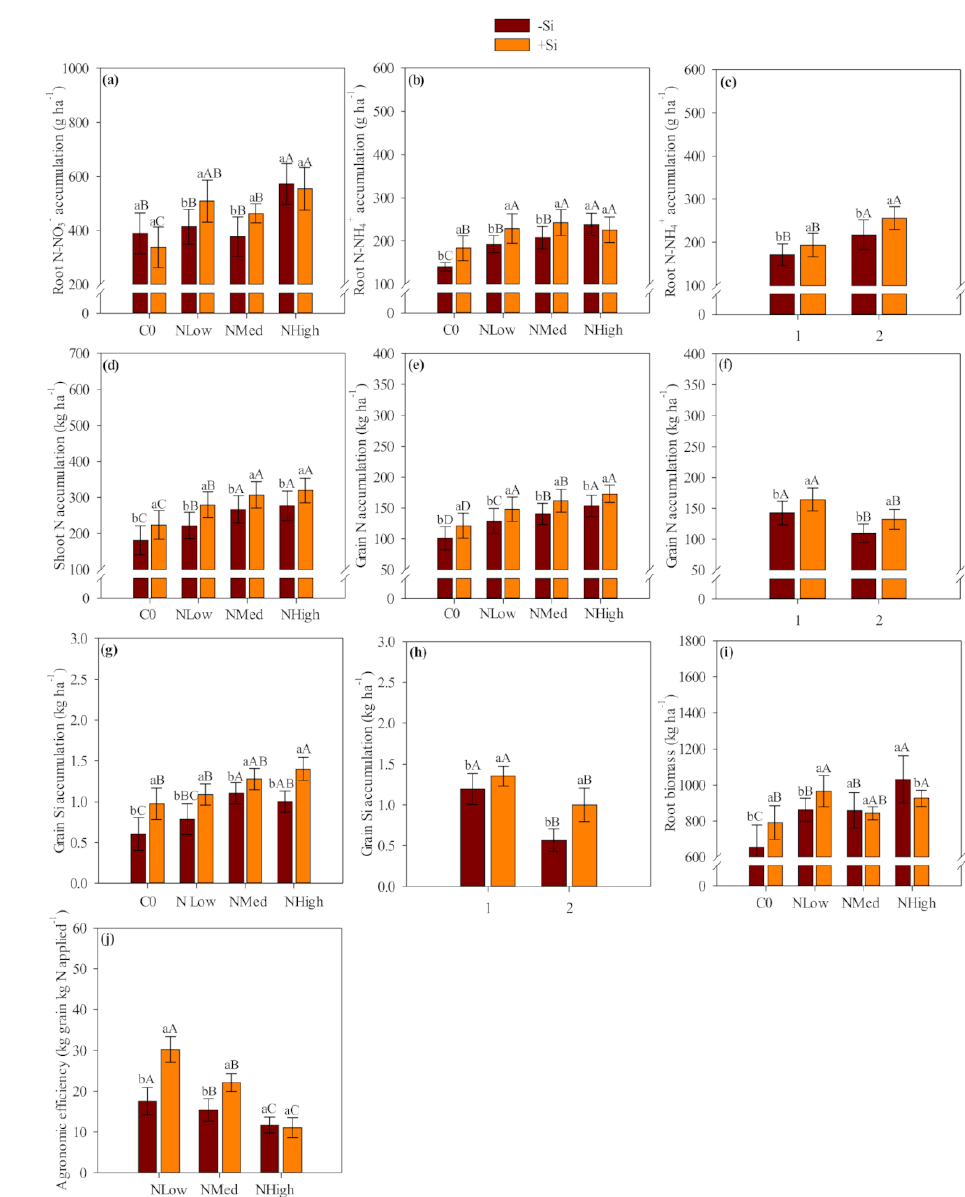
Figure 1. Maize root nitrate (N-NO 3 − ) accumulation ( a ), root ammonium (N-NH 4 + ) accumulation ( b , c ), shoot N accumulation ( d ), grain N accumulation ( e , f ), grain Si accumulation ( g , h ), root biomass ( i ) and agronomic efficiency ( j ) affected by the interaction between Si amendment application and N levels or by the interaction between Si amendment application and years of